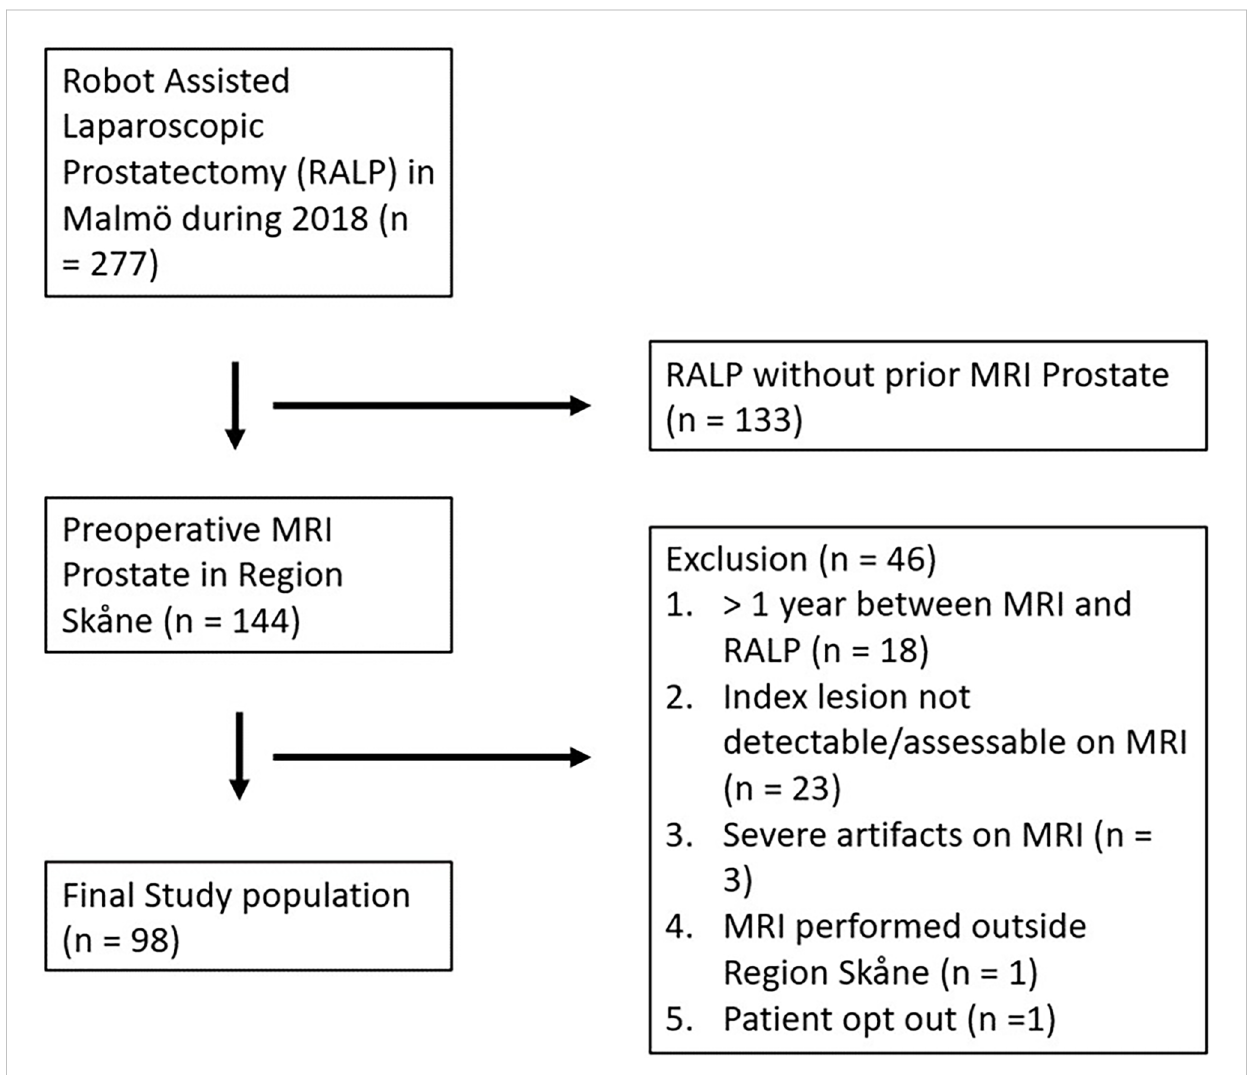
FIGURE 1 Flow diagram of patient